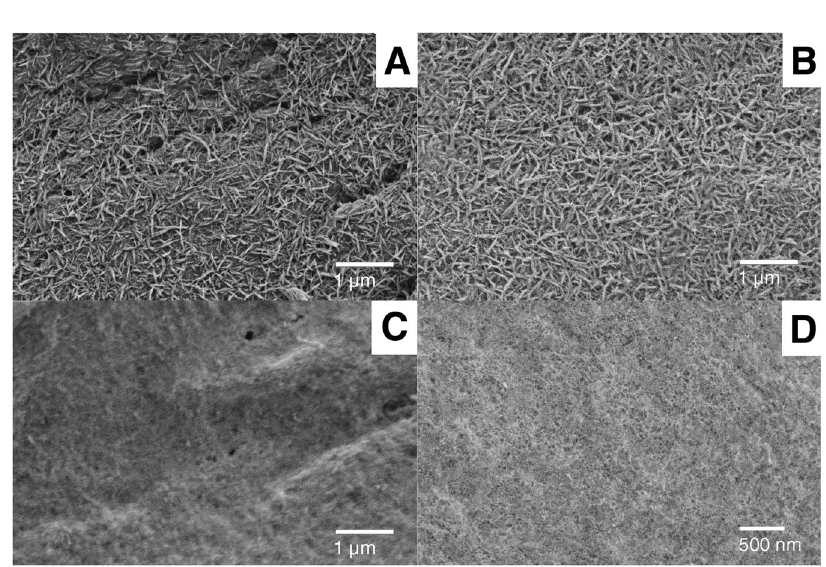
Fig. 10 SEM images of coated PEEK surfaces, prior to and after insertion in the skin: A PEEK + HA before insertion, B PEEK + HA after insertion, C PEEK + ZrP before insertion, D PEEK + ZrP after